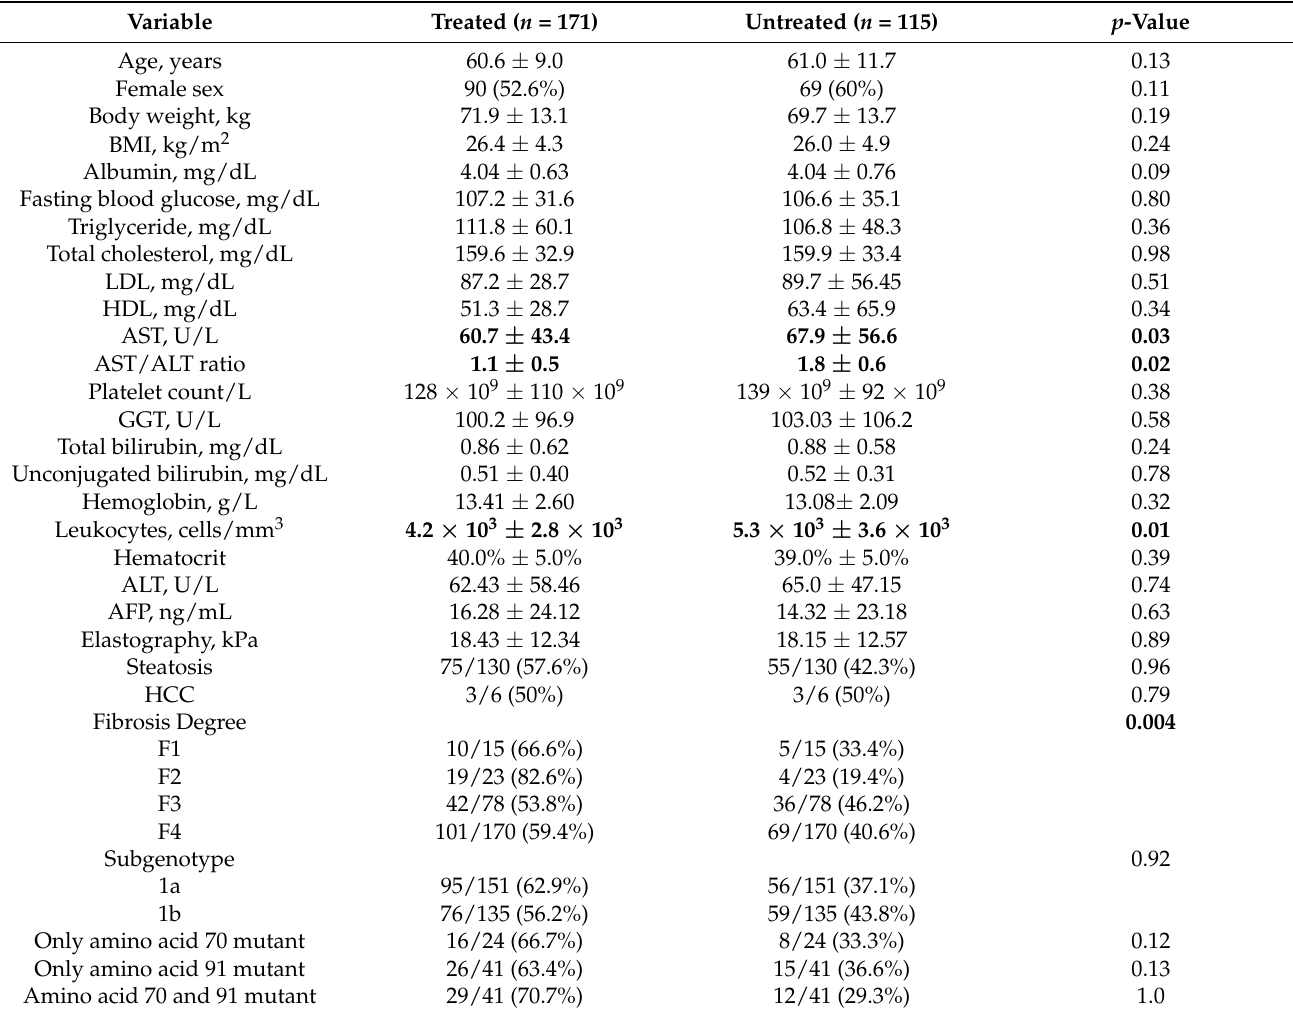
Table 1. Demographic and biochemical characteristics of the study population with and without treatment (mean ± SD and case